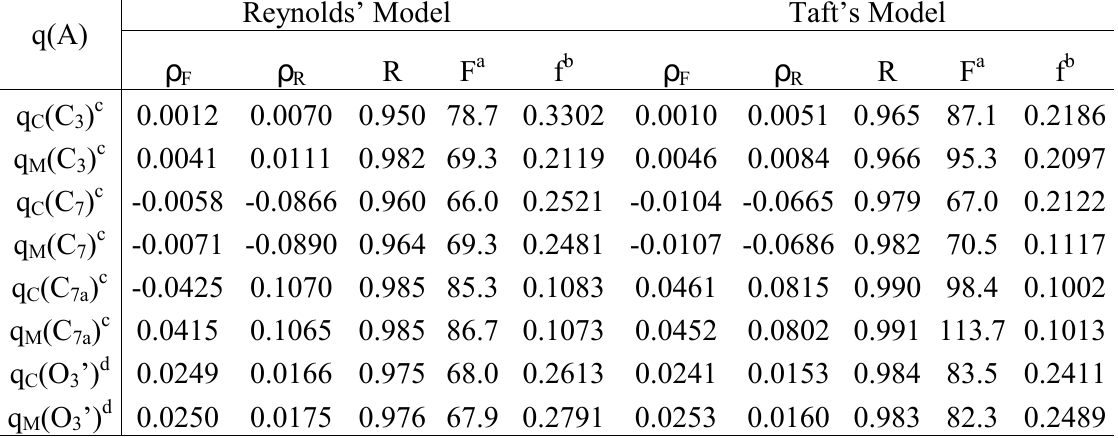
Table 3 . DSP correlations for AM1 charge densities and Mulliken charges of compounds